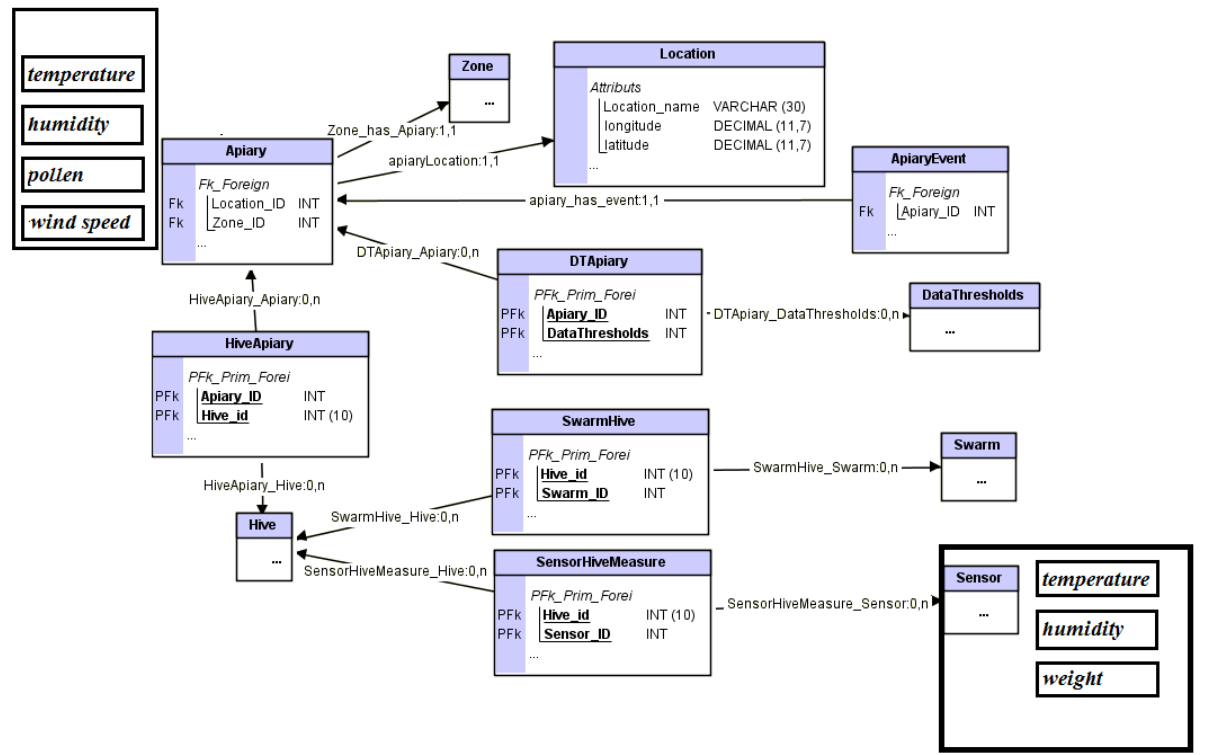
Figure 7. Excerpt from the data